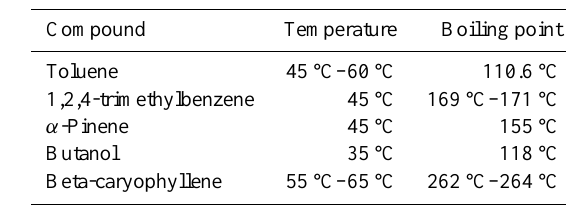
Table 2. Operating temperatures of the dilution system for the com- pounds